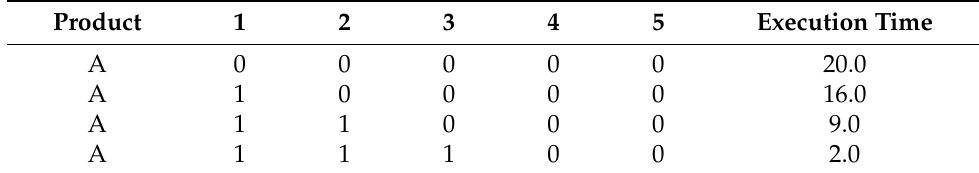
Table 3. Transformation of